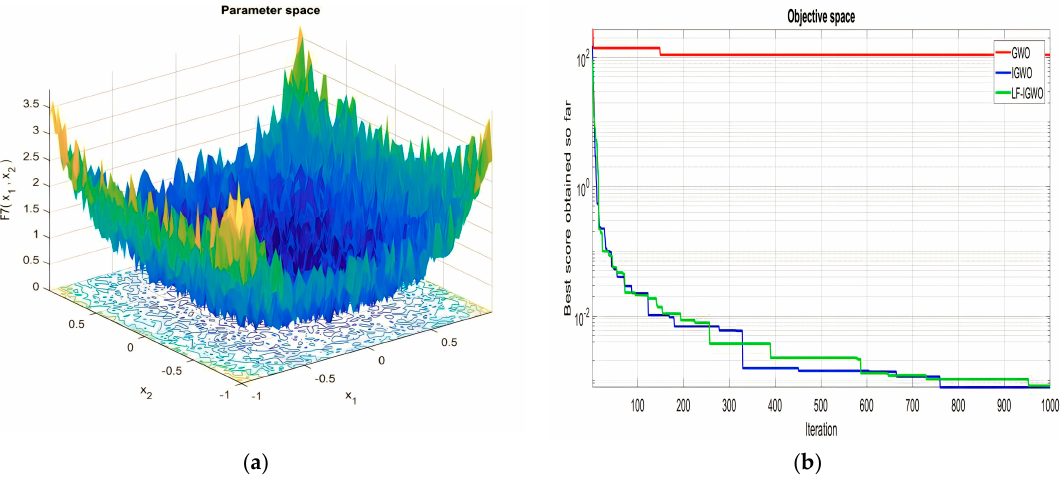
Figure 8. ( a ) Search space for unimodel function F06 ( b ) Comparison of convergence curve for F06.